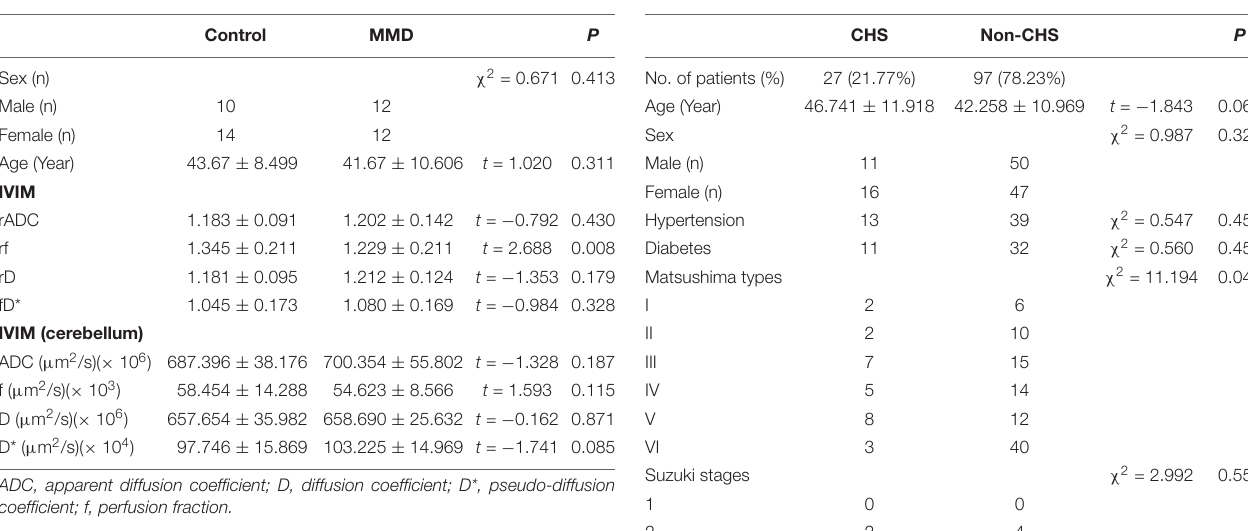
TABLE 2 | Examination results of the MMD and control groups. TABLE 3 | Clinical characteristics of the patients in the CHS and non-CHS